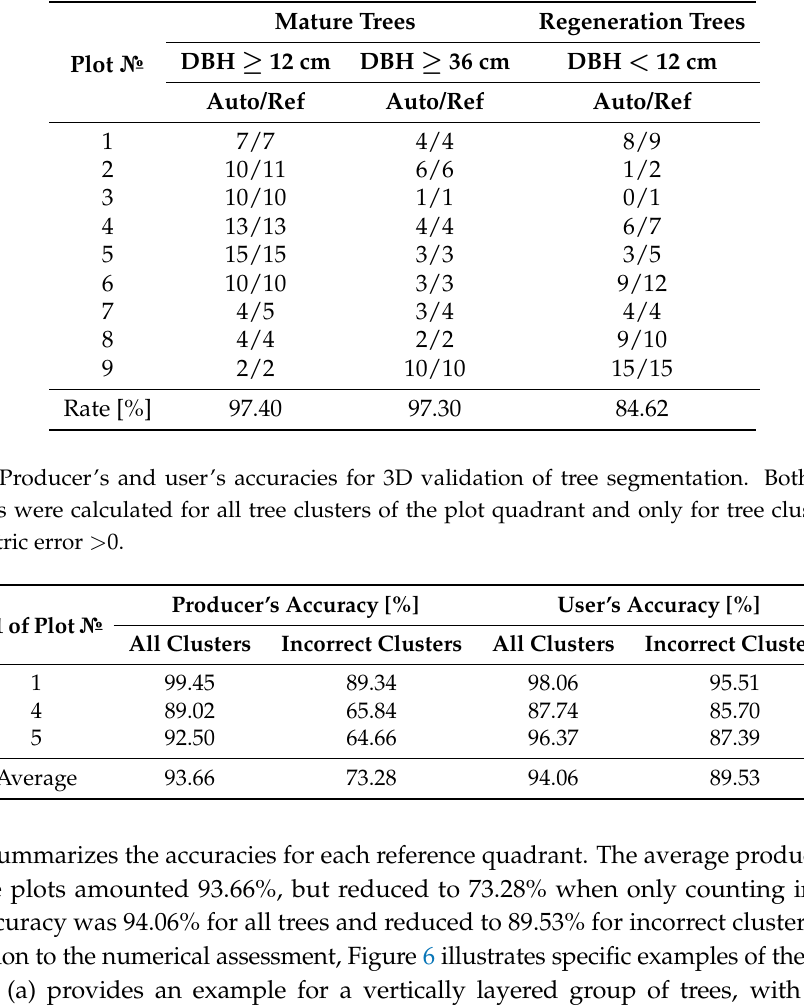
Table 2. Rates for automatically detected trees (auto) compared to the references measured in the field (ref).